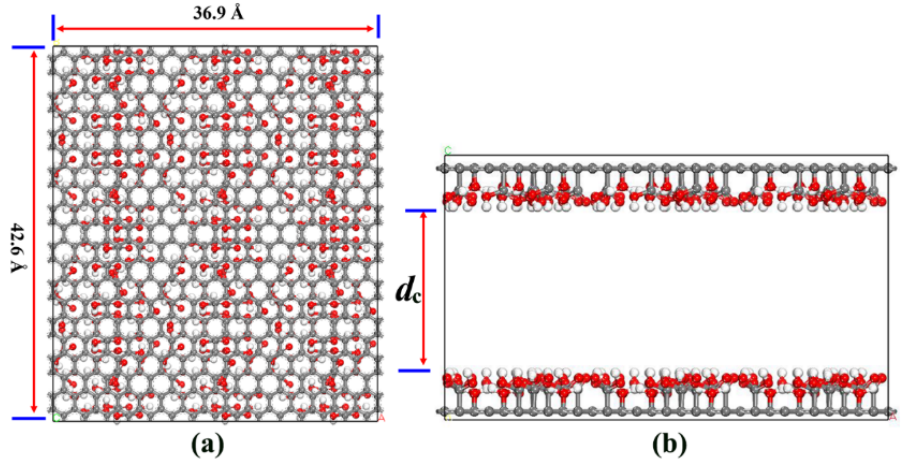
Figure 4. UCAC model diagram ( a ) Top view; ( b ) Side view.